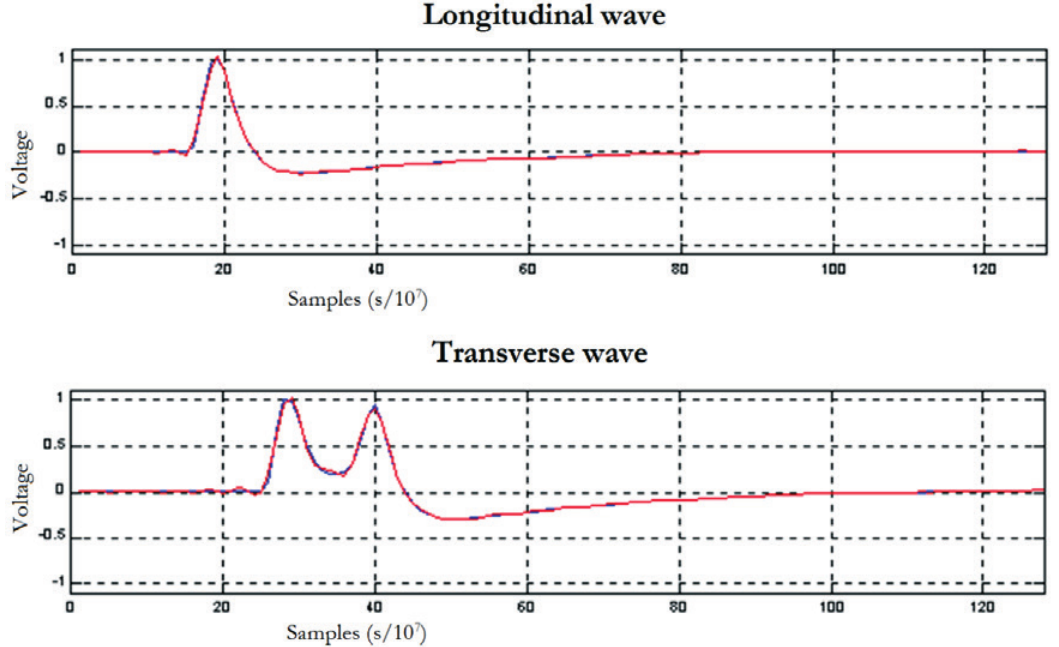
Longitudinal and transverse waves: Fourier series approximation (red) and signals digitally recorded (blue – partially hidden by the Fourier approximation) are almost